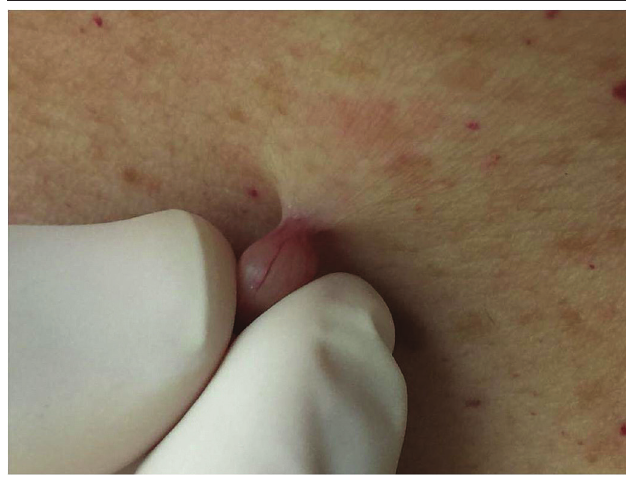
figura 1 − Lesão normocrômica pedunculada no abdômen